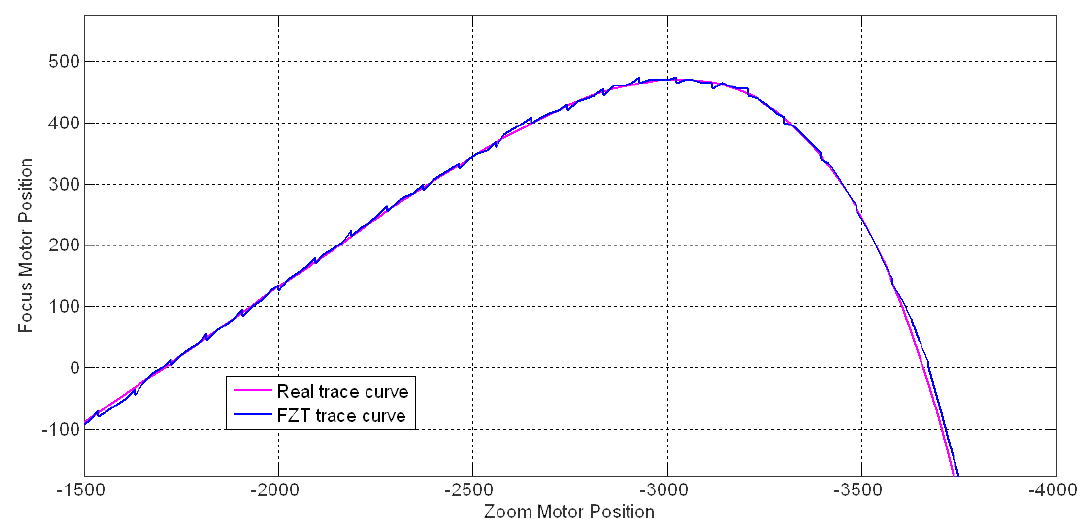
Figure 13. FZT trace curve for a 3 m stationary object.